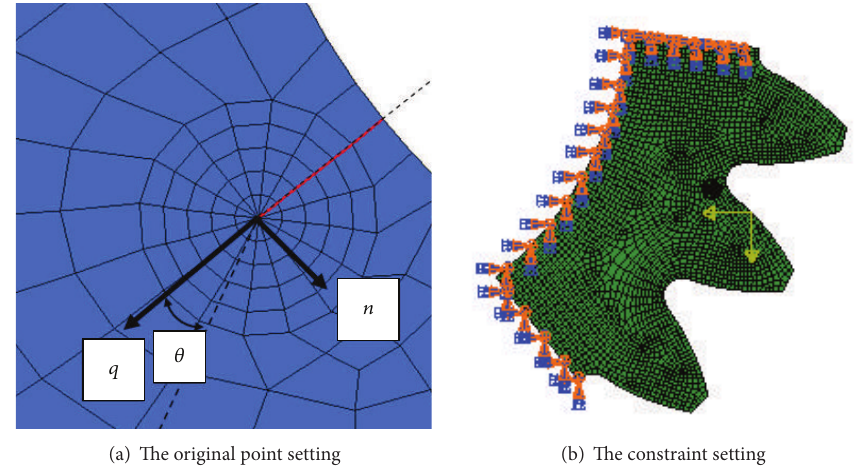
Figure 6: The 2D FEM settings.